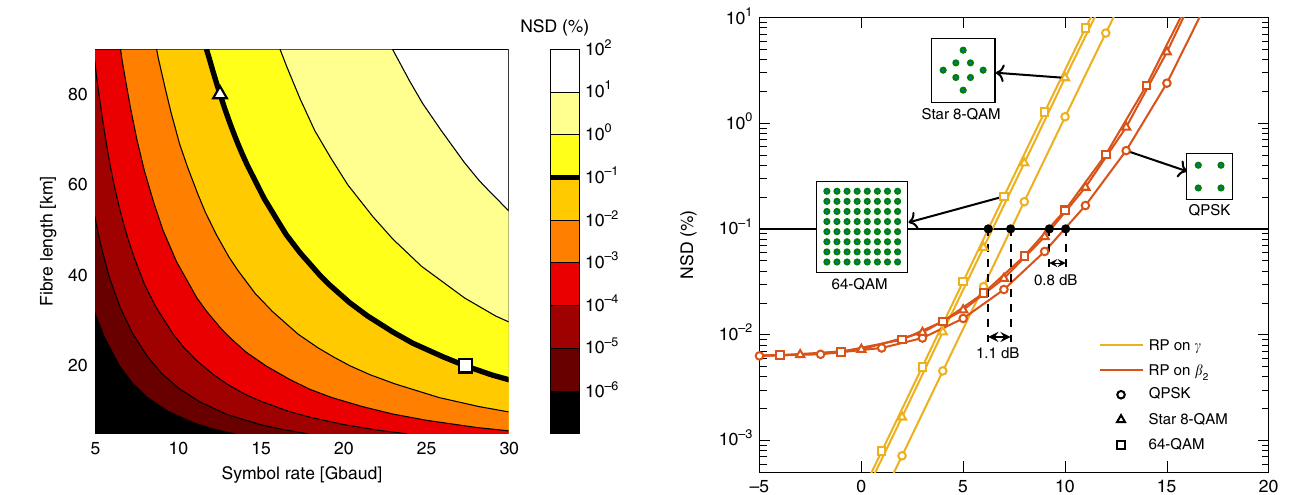
Fig. 7 NSD for RP on β 2 for different values of fi bre length and symbol rate. The system consists of a 80 km NZDSF with fi xed input power 5 dBm. The triangular marker on the top of the fi gure is associated with the distance of 80 km and symbol rate of 12.55 Gbaud. The square marker on the bottom right is associated with the distance of 20 km and symbol rate of 27.38 Gbaud. Both markers lie on the thick black line representing a constant 0.1% fi rst-order RP approximation. The performance of star 8-QAM and 64-QAM are almost the same for the considered input powers. The gap between QPSK and 64-QAM for the 0.1% threshold crossing is 0.8 dB for RP on β 2 and 1.1 dB for RP on γ . The higher gap for RP on γ might indicate that this model is more sensitive to changes in the modulation format than RP on β 2 .